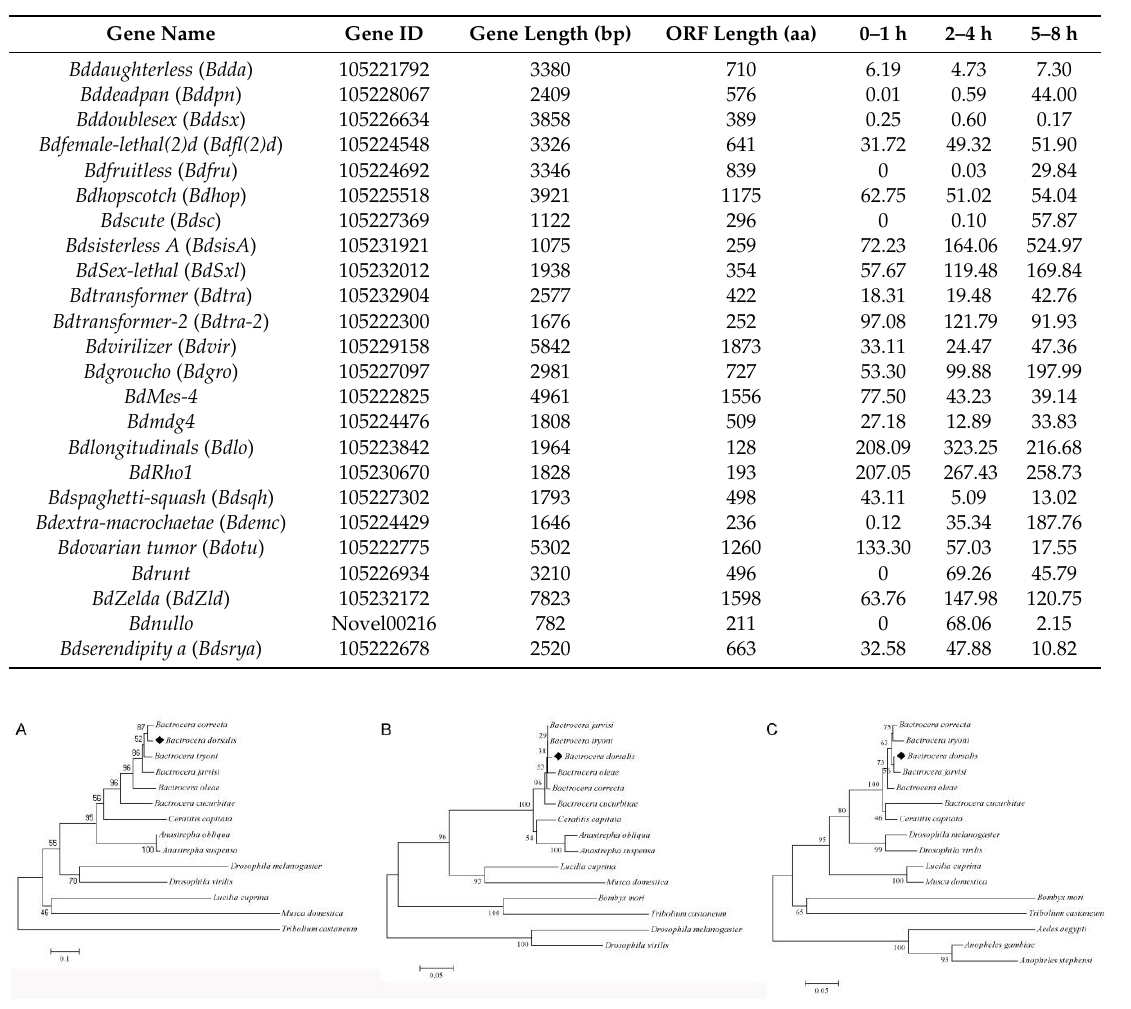
Figure 6. Neighbor-joining tree of insect transformer (TRA), transformer-2 (TRA-2) and doublesex (DSX) amino acid sequences. The scale represents the mean character distance.